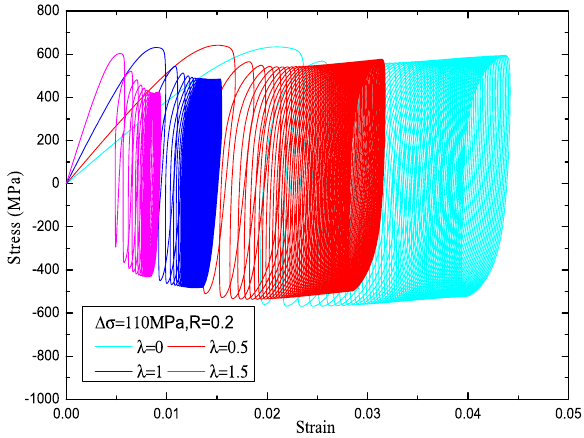
Fig. 6 Hysteresis loops for inclined-crack specimens with different biaxial stress ratios